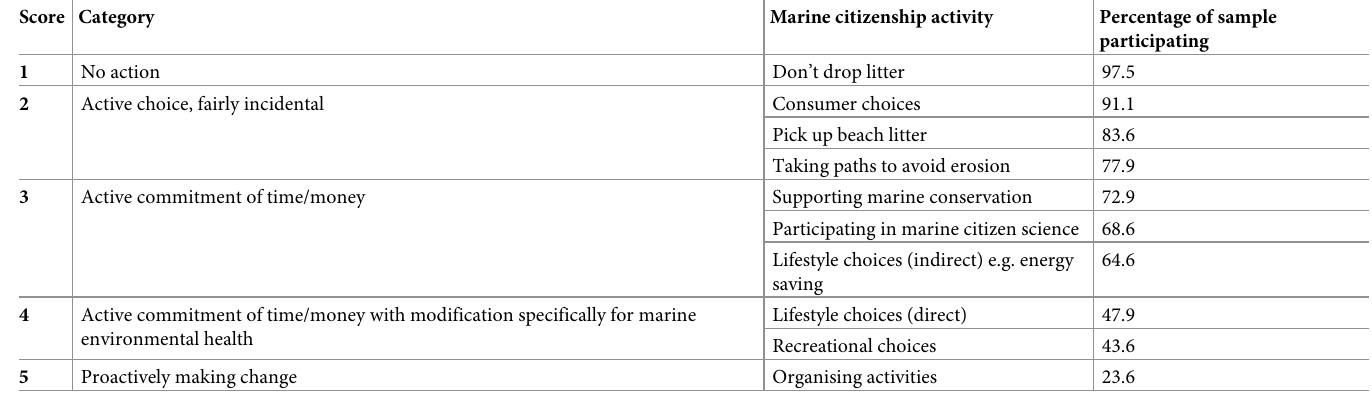
Table 1. Marine citizenship scoring metric. Marine citizenship activities are categorised according to level of commitment and modification of life and given a score which increases with ‘thickness’ of the citizenship activity. Score